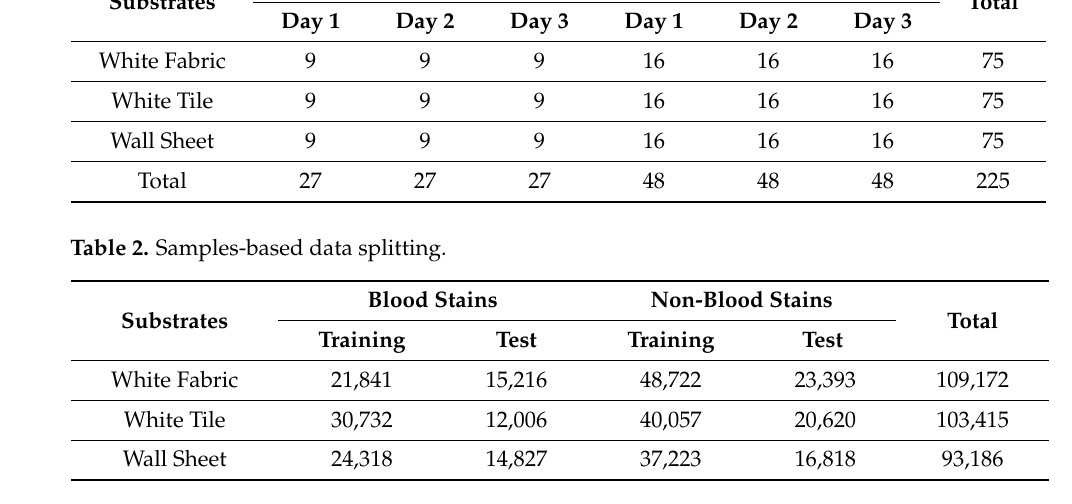
Table 3. Pixel-based data